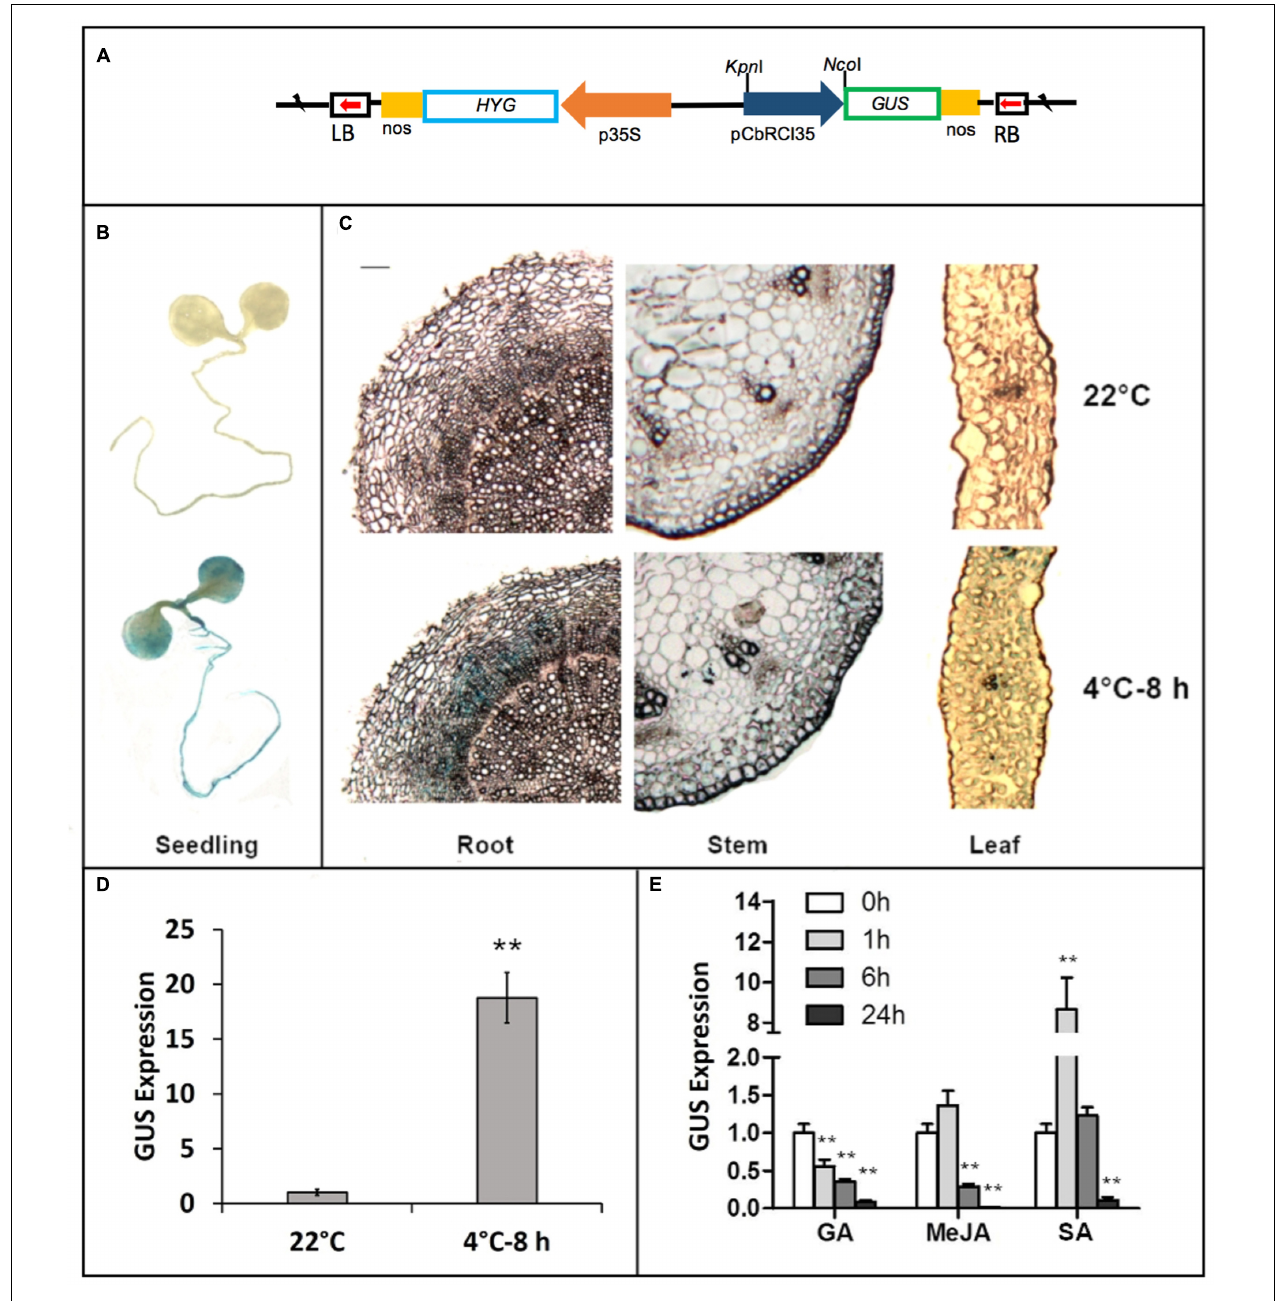
FIGURE 3 | Characterization of CbRCI35 promoter activity using GUS report system and qPCR. (A) The GUS reporter gene was under the control of the CbRCI35 promoter in pCbRCI35::GUS plasmid. (B) GUS staining of 2.5-week-old transgenic Arabidopsis seedlings containing pCbRCI35::GUS fusion growing at 22 ◦ C or exposed to 4 ◦ C for 8 h. (C) Semi-thin section of leaf, stem and root tissues from 4.5-week-old transgenic seedlings containing pCbCOR15a::GUS fusion growing at 22 ◦ C or exposed to 4 ◦ C for 8 h after GUS staining. The bar represents 0.001 cm. Transcript level of GUS reporter gene driven by CbRCI35 in transgenic plants growing at 22 ◦ C was tested after exposed to 4 ◦ C for 8 h (D) or treated by GA, MeJA, or SA for time indicated (E) . Actin2 gene was performed as an internal control. Data are means ± SD ( n = 3, ∗∗ P < 0.01).